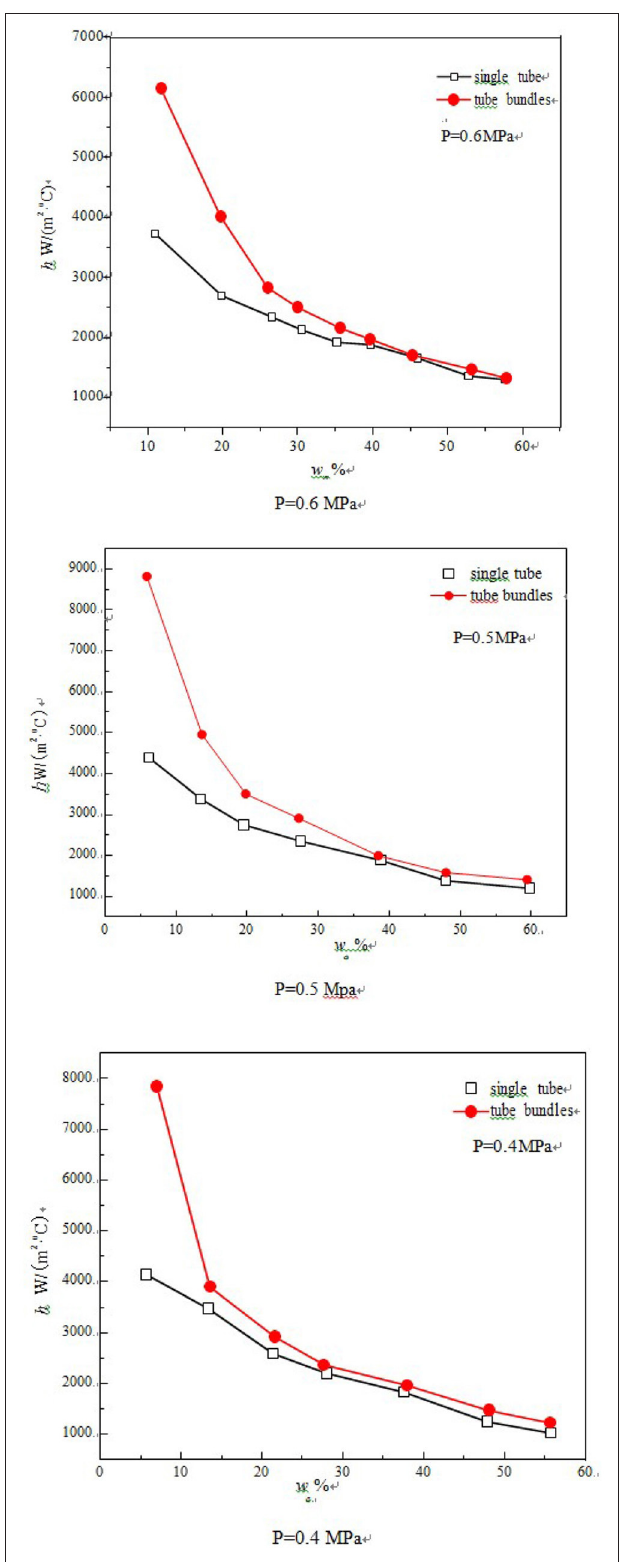
FIGURE 5 | Comparison of condensation heat transfer coefficient between single tube and tube bundles.